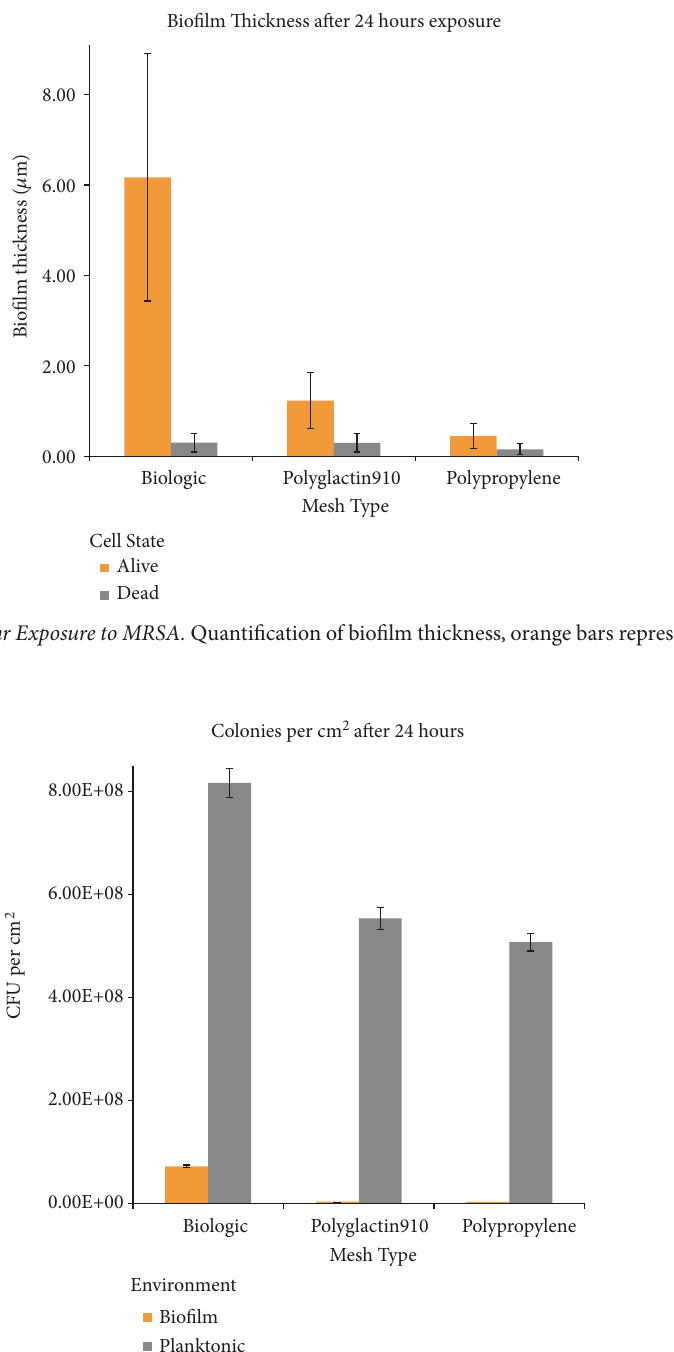
Figure 5: Quantification of Colony-forming Units per cm 2 after 24 Hours. Dark grey bars represent attached biofilm bacteria and light grey bars planktonic